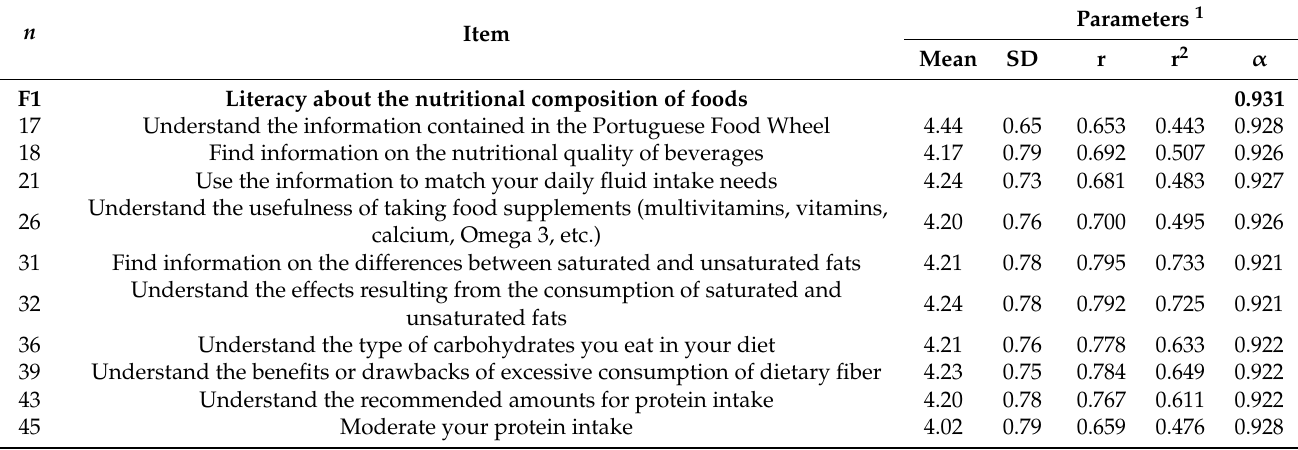
Table 8. Internal consistency of the items in the final